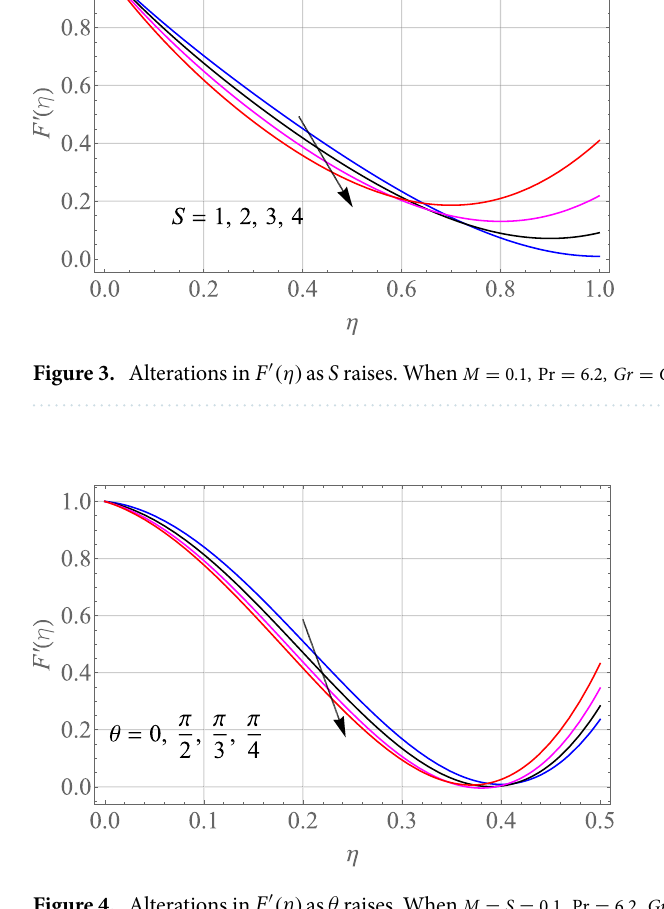
Figure 4. Alterations in F ′ (η) as θ raises. When M = S = 0.1, Pr = 6.2, Gr = Gc = 0.2, Ec = 1, Nb = Nt = 0.3, Sc = 0.3 .